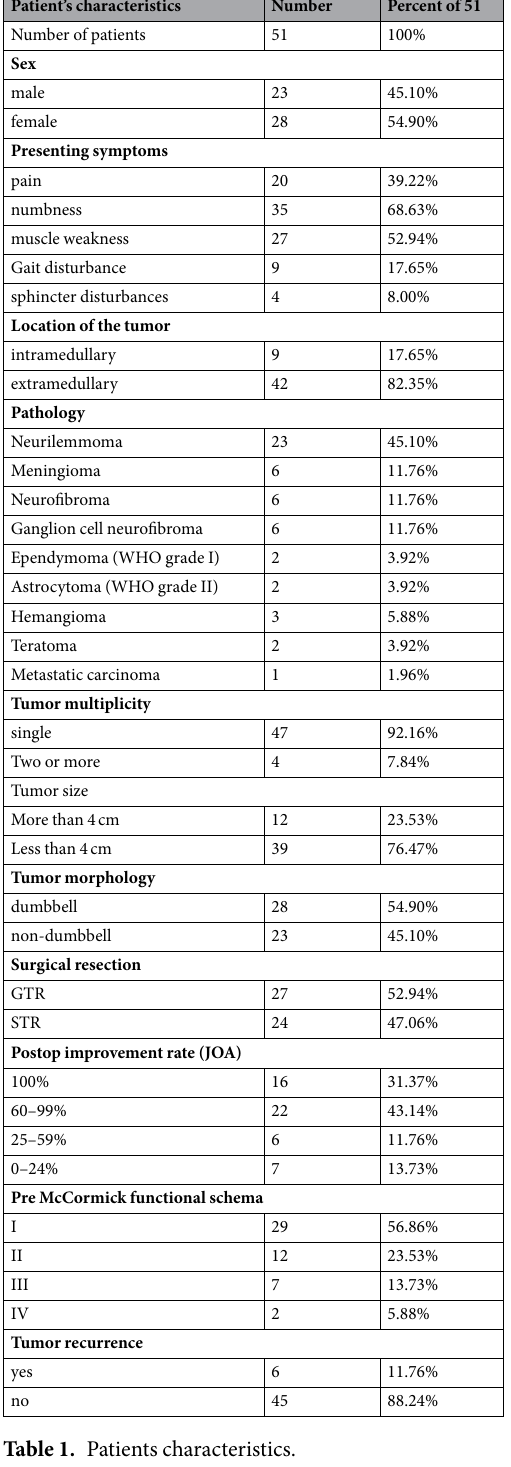
Table 1. Patients